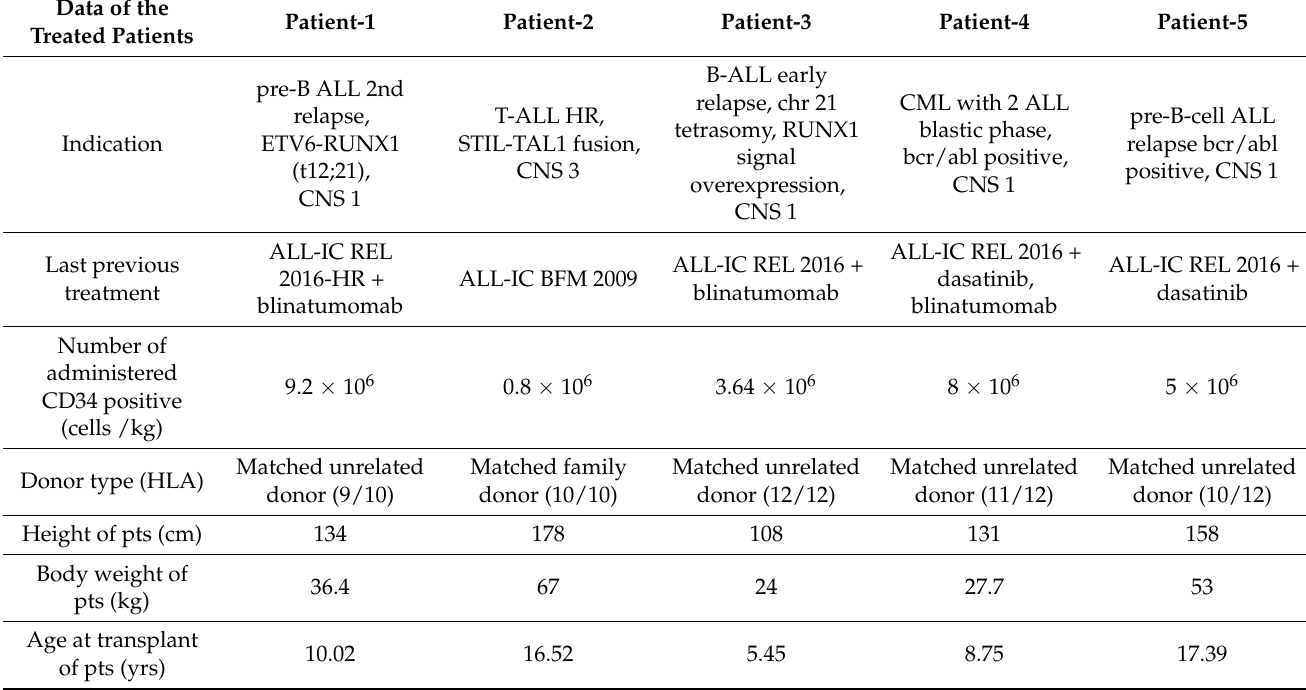
Table 1. Data of the treated patients from the view of pediatrician, indications, last previous treat- ments, infused cell (CD34/kg), donor HLA matching, biometric data of patients, GVDH prophylaxis, time to engraftment from HSCT, adverse events, conditioning regimen, follow-up time. (AE: adverse event, ALL: acute lymphoblastic leukemia, ALL-IC REL: The Acute Lymphoblastic Leukemia